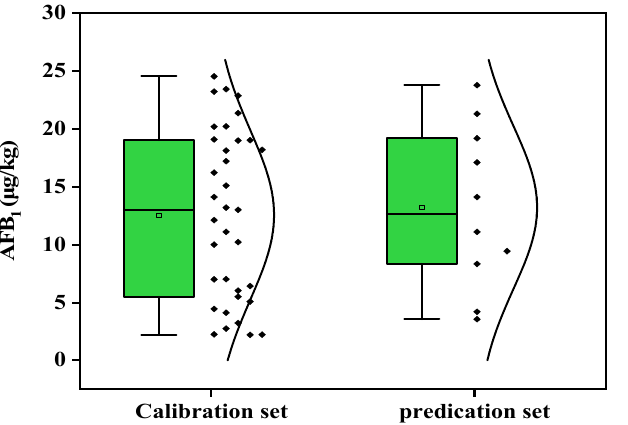
Figure 1 . Distribution and reference AFB 1 concentrations in peanuts for calibration and validation sets.